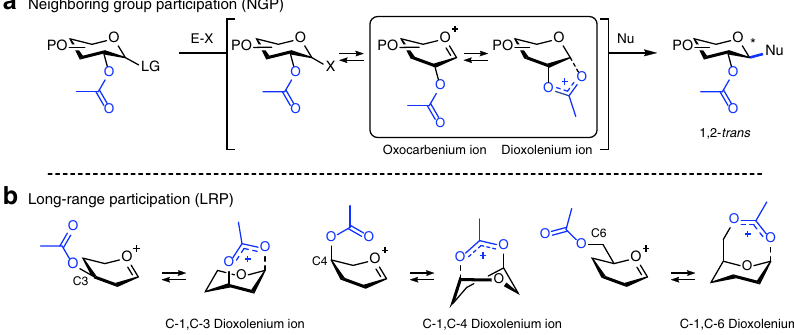
Fig. 1 NGP and LRP in glycosylation reactions offers an opportunity to control the stereoselectivity of glycosylations. Schematic representation of possible reactive intermediates in NGP ( a ) and LRP ( b ). P protection group, E – X promoter system, Nu